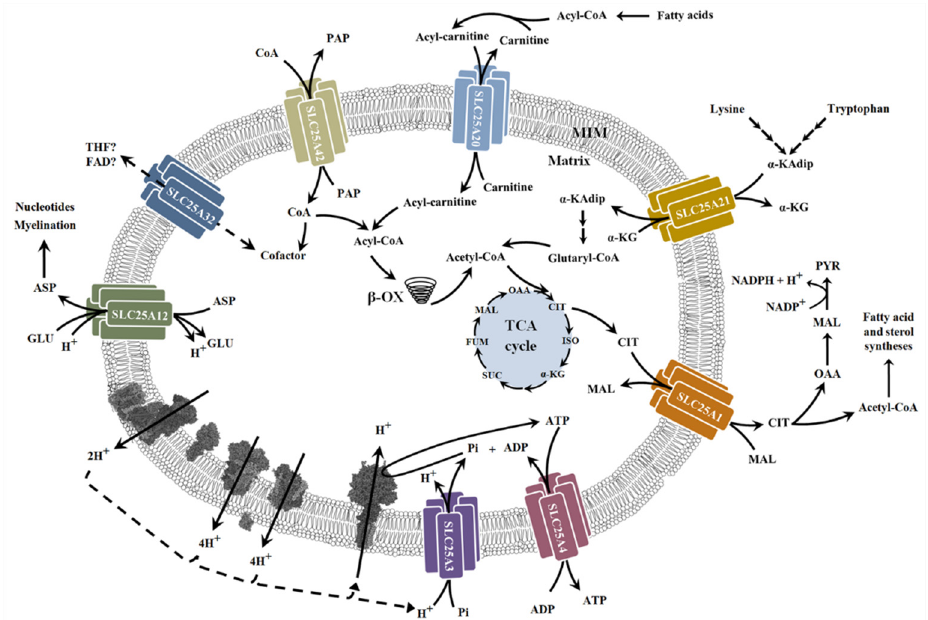
Figure 3. Metabolic role of the SLC25A members involved in NMDs. Mitochondrial carriers are indicated with the coding gene name, and the main transported substrates, when known, are reported. α -KAdip, α -ketoadipate; α -KG, α -ketoglutarate; ASP, aspartate; β -OX, β -oxidation; CIT, citrate; CoA, coenzyme A; FAD, flavin adenine dinucleotide; FUM, fumarate; GLU, glutamate; ISO, isocitrate; MAL, malate; MIM, mitochondrial inner membrane; OAA, oxaloacetate; PAP, adenosine 3 ′ ,5 ′ -diphosphate; Pi, inorganic phosphate; PYR, pyruvate; SUC, succinate; TCA, tricarboxylic acid; THF, tetrahydrofolate. Table 3. Impaired mitochondrial carrier proteins associated with neuromuscular phenotypes. The amino acids and nucleotides mutations are also reported. For the functions of the listed proteins see Figure 3.